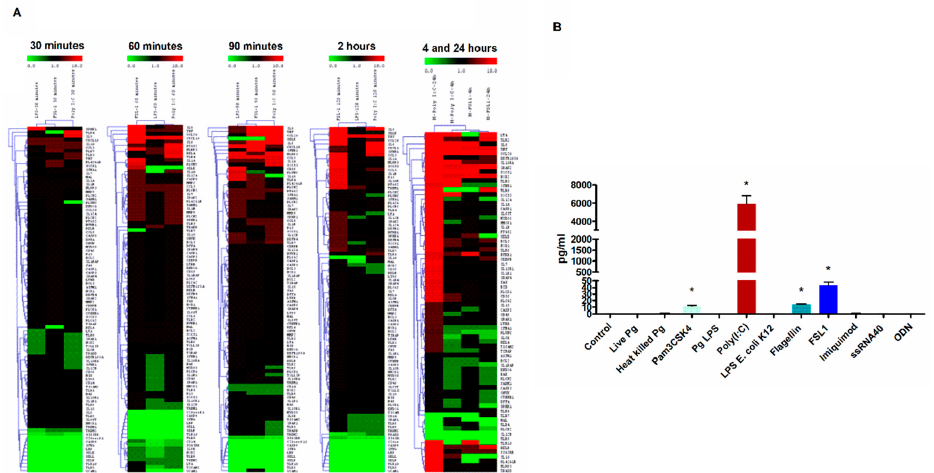
Figure 1. TLR3 stimulation of human gingival epithelial cells (HGECs) leads to robust activation proinflammatory signaling: the cells were treated with various TLR ligands for 24 h and the supernatant was subjected to TNF measurement using ELISA. TLR3 stimulation by poly I:C induced robust TNF cytokine induction ( A ). HGECs were incubated with E. Coli LPS (1 µ g / mL), FSL-1 (1 µ g / mL) and poly I:C (5 µ g / mL) for 30, 60, 90, 120 min and 4 and 24 h. Total RNA was isolated, converted to cDNA and customized qPCR-Arrays were analyzed. The ∆∆ CT values were used to generate the heatmaps based on two-way hierarchical clustering with MeV v4.1 software (rows = genes, columns = samples) using the values from two independent experiments. The color scale indicates relative expression: Red, above mean; green, below mean; and black, below background ( B ). Statistical comparison was done for ELISA by one-way ANOVA followed by Tukey’s multiple comparison test (* p < 0.05) and results are represented as mean ± SE ( n = 3) from three independent experiments.